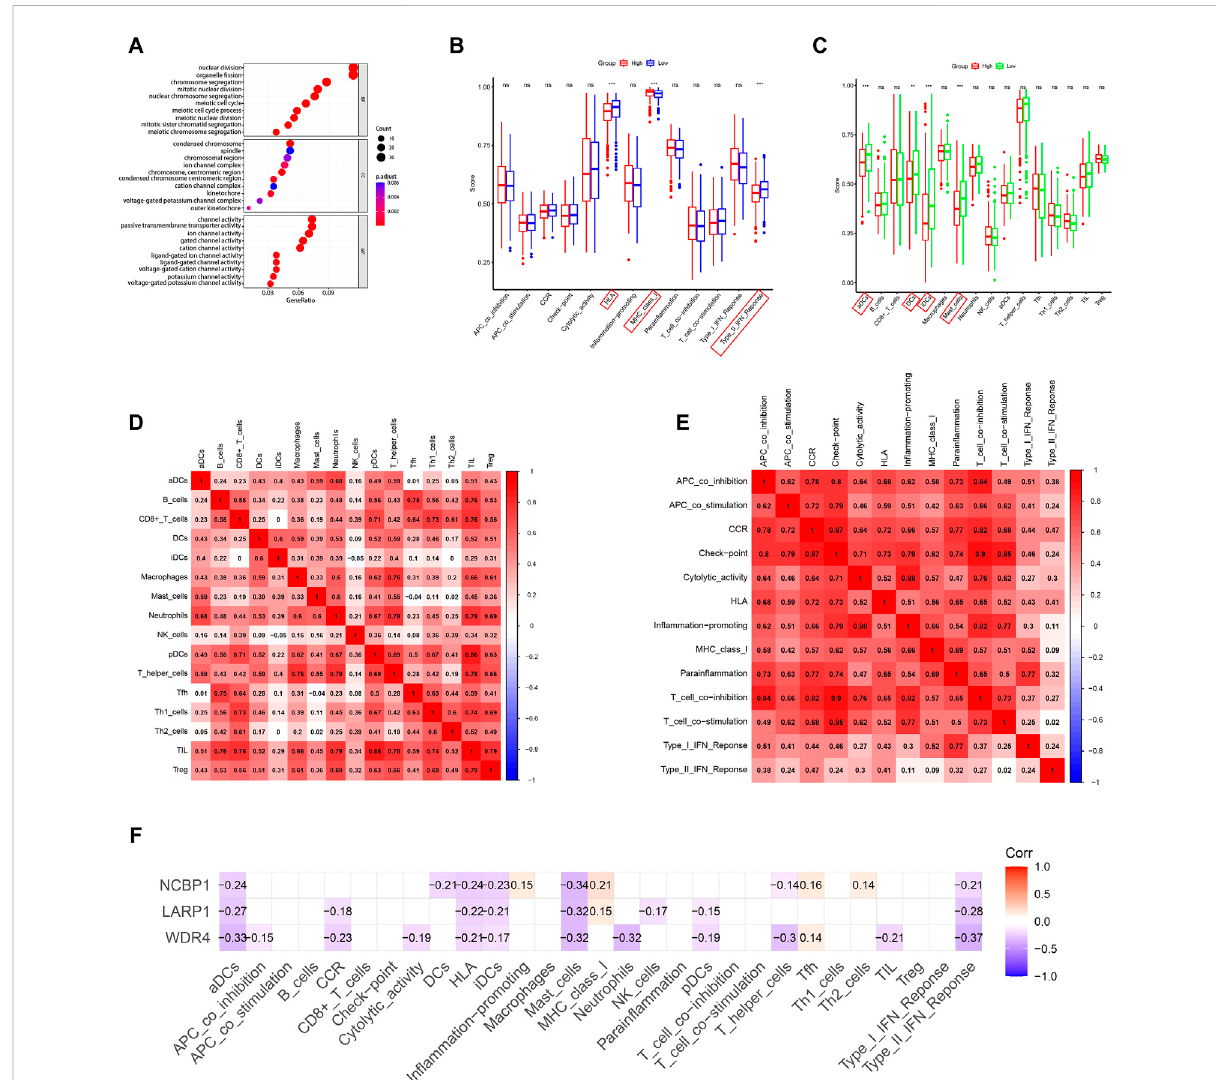
FIGURE 6 GOandimmuneanalysesaccordingtoDEGsamongtworiskgroupsintheTCGAqueue. (A) BubblegraphforGOfunctionalannotationanalysis (the smaller bubble means fewer genes are enriched, and the increasing depth of red means the differences are more obvious). (B) By contrast, enrichment fractions of 16 kinds of immune cells in the low- (bule box) and high-risk (red box) groups. (C) By contrast, enrichment values of 13 immune-related pathways among low-risk (green box) and high-risk (red box) groups. Correlations between (D) immune cells and (E) immune functions in LUAD patients. (F) Correlation analysis of WDR4 , LARP1 , and NCBP1 with immune cells and immune function. * p < 0.05; ** p < 0.01; *** p <